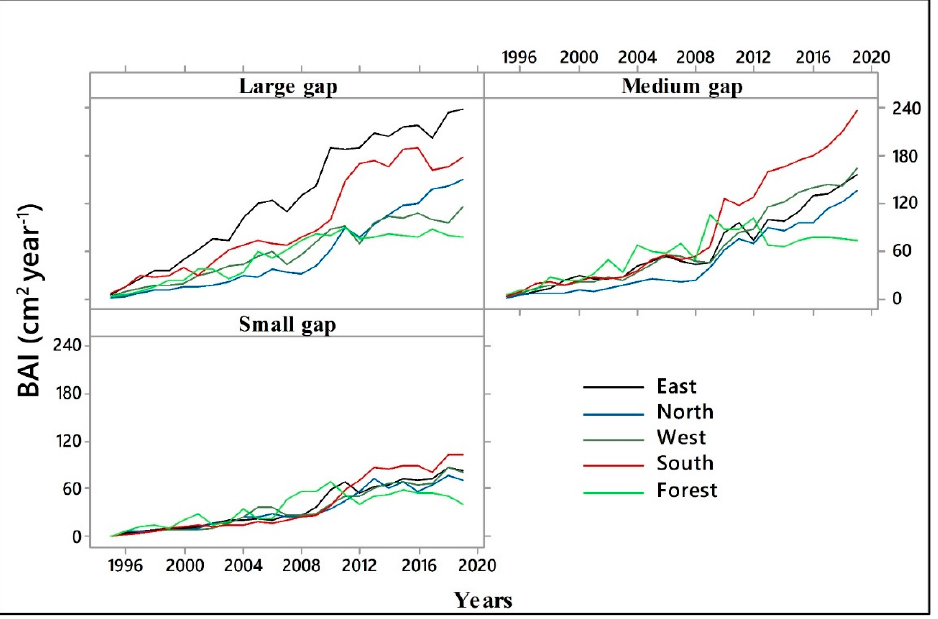
Figure 5. Basal area increment (BAI) values trend for European beech in each size gap and for each cardinal point.